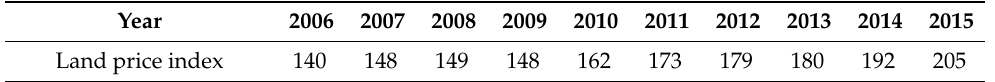
Table 5. Comprehensive land price index of Hangzhou from 2006 to